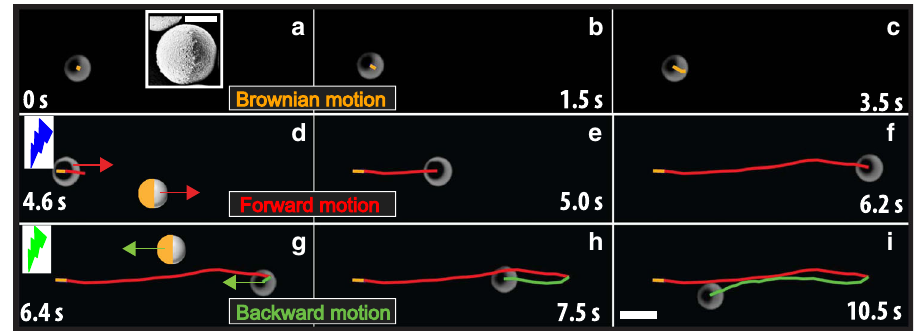
Fig. 1 Reversing the propulsion direction using different wavelengths of light. a – i Time-lapsed bright fi eld microscopy images are showing the mode of the motion and the overlaid trajectories revealing the typical trajectories, respectively. The half-Au-coated anatase TiO 2 particles are dispersed in 12 vol% H 2 O 2 solution. Note the bright side is the TiO 2 side while the dark side is the half-gold-coated cap. In the schematic, the gold colour corresponds to the gold-coated side of the particle, whereas the light brown represents the sintered TiO 2 . Colour of lightning bolt illustrates the wavelength of light used in the experiment. a – c Brownian motion of the particle. Inset shows a scanning electron microscopy (SEM) image of the Au-coated TiO 2 Janus particle. d – f The swimmer propels in the forward direction under illumination UV light. g – i The swimming direction of the particle is reversed after a switch to green light. The arrow depicts the direction of the propulsion. The brightness and contrast of the images are adjusted using ImageJ. Scale bar is 5.0 μ m. Scale bar in the inset is 2.0